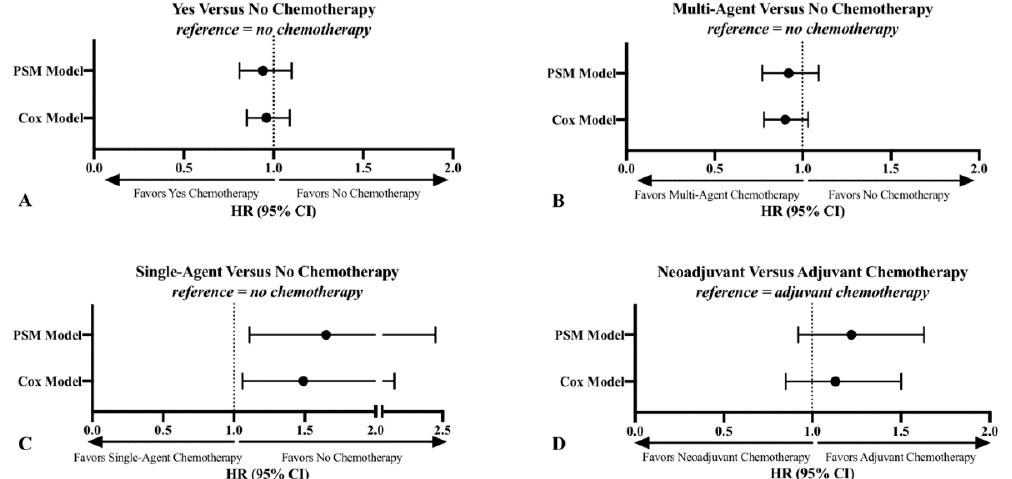
Figure 2. Cox proportional hazards model and PSM results of the association between chemotherapy use ( A ), multi-agent chemotherapy use ( B ), single-agent chemotherapy use ( C ), and neoadjuvant chemotherapy use ( D ) with OS in patients with primary high-grade extremity and trunk STS in the NCDB from 2004–2016. CI = confidence interval; HR = hazard ratio; NCDB = National Cancer Database; OS = overall survival; PSM = propensity score matching; STS = soft tissue sarcoma.